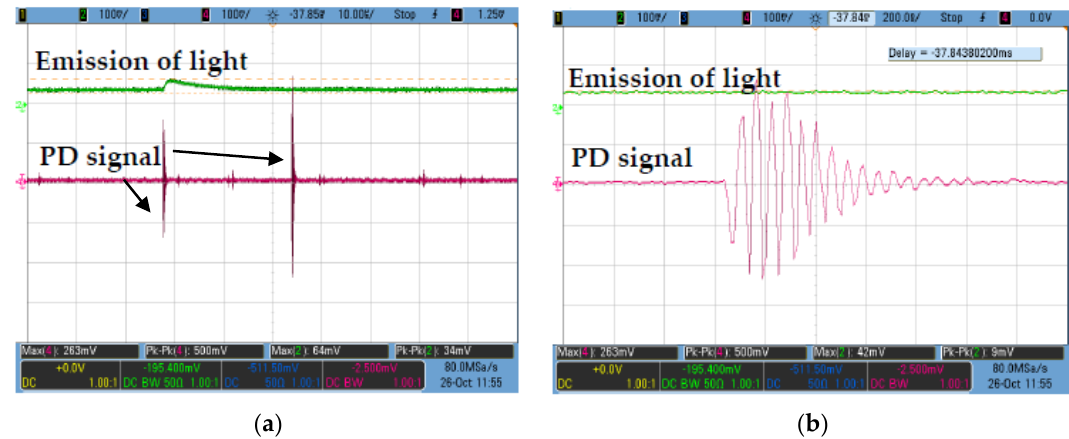
Figure 2. ( a ) Output voltage of the PD signal, ( b ) zoom in view for the output voltage of the PD signal waveform measured by impedance matching circuit (IMC).